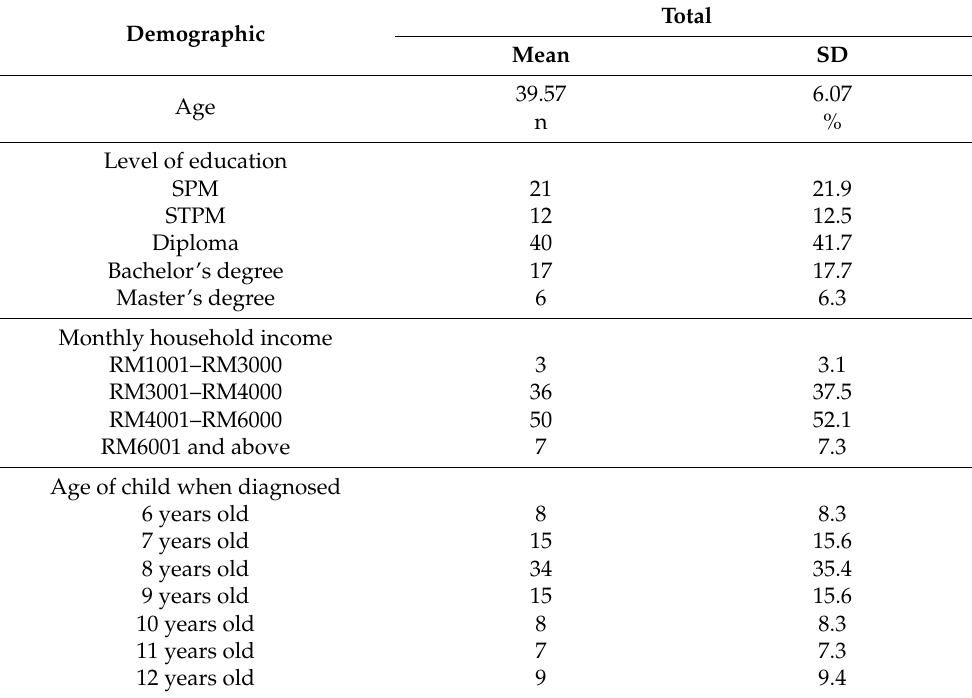
Table 1. Sociodemographic information of participants.